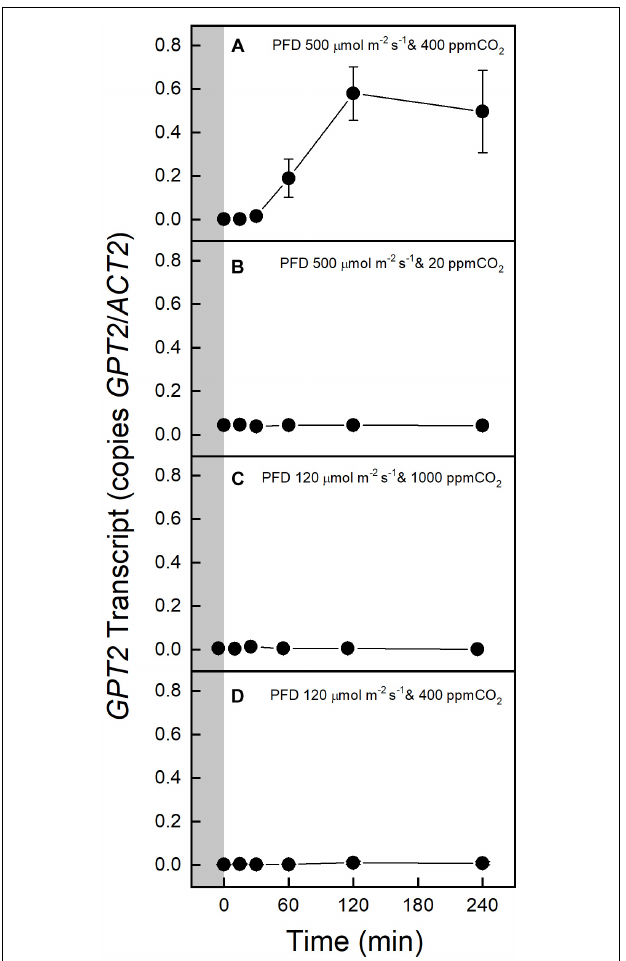
FIGURE 2 | Expression of GPT2 in Col-0 before and after transfer to an altered light or CO 2 environment. The gray block indicates sampling in growth conditions, PFD 120 µ mol m − 2 s − 1 and 400 ppm CO 2 . Panels A–D show responses to various light and CO 2 treatments as indicated on the figure. n = 5.